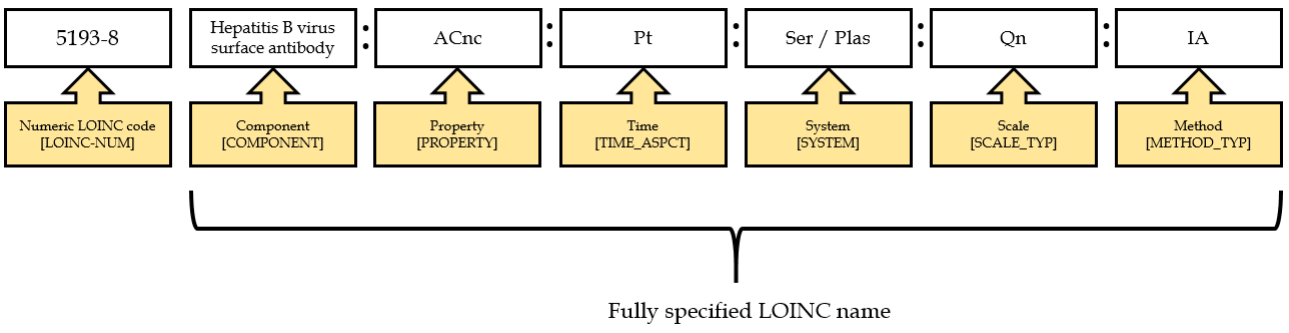
Figure 1. An example of a LOINC name and code.